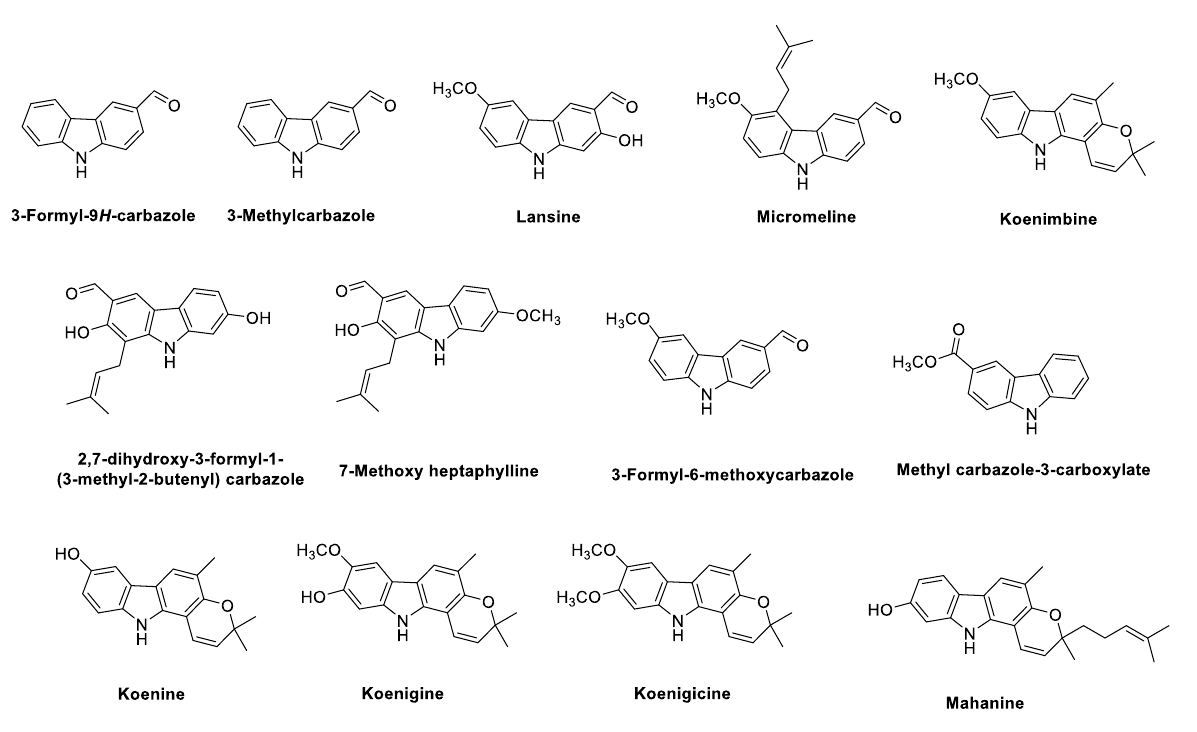
Figure 5. Potential phyto-carbazole alkaloids from the species of the genus Micromelum .